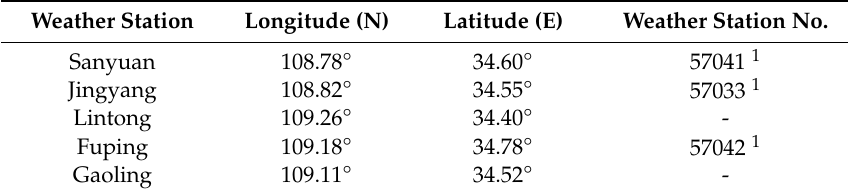
Table 2. Location information of five weather